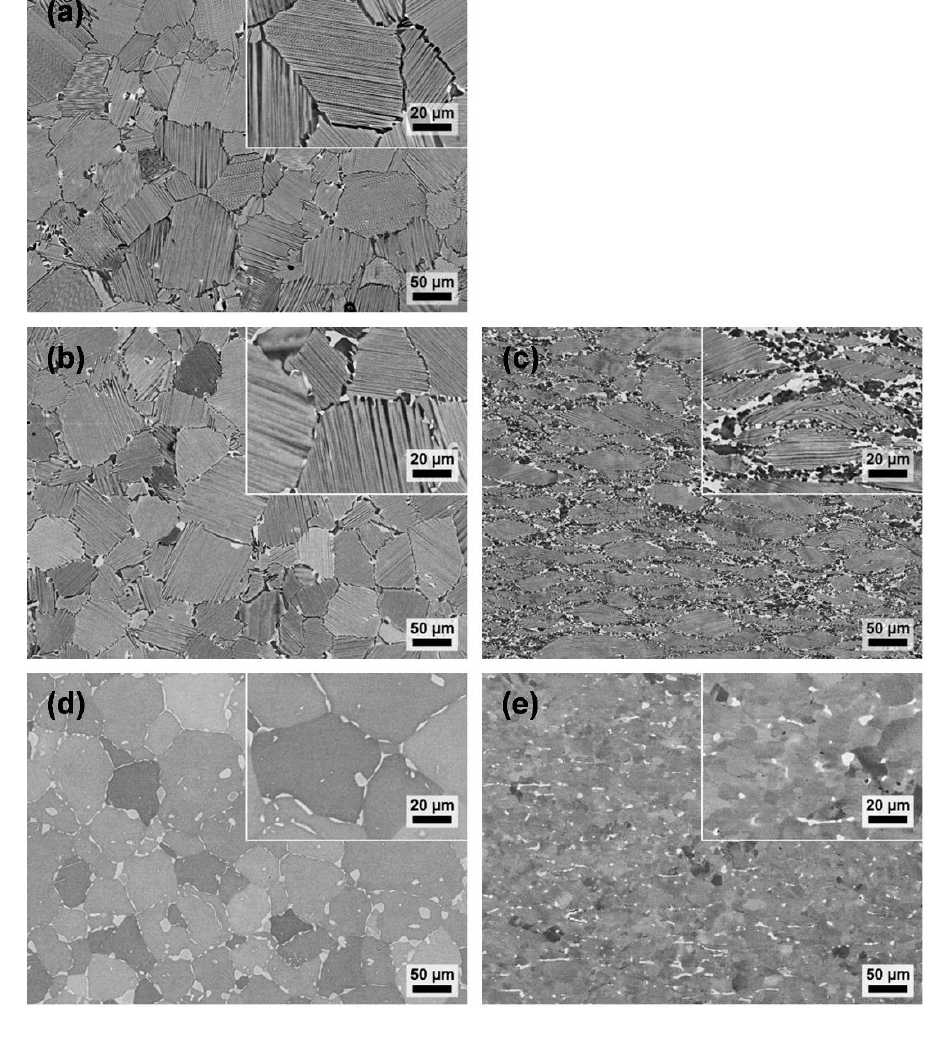
Figure 3. SEM micrographs taken in the BSE mode. ( a ) HIPed starting material at room temperature; ( b – e ) Microstructures of specimens from two hot forming experiments heated up to process temperatures of ( b , c ) 1150 °C and ( d , e ) 1250 °C and quenched ( b , d ) before and ( c , e ) after deformation. The γ phase appears dark grey, α 2 /α as light grey, and β o /β almost white. The load direction is vertical